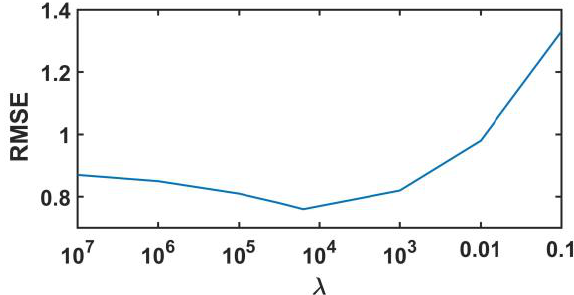
Figure 25. Root mean square error changes with λ .